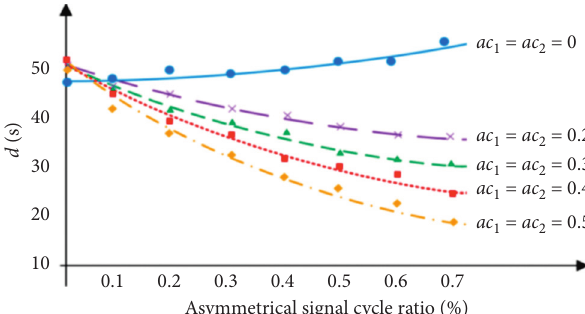
Figure 9: Asymmetric signal cycle ratio on the phase